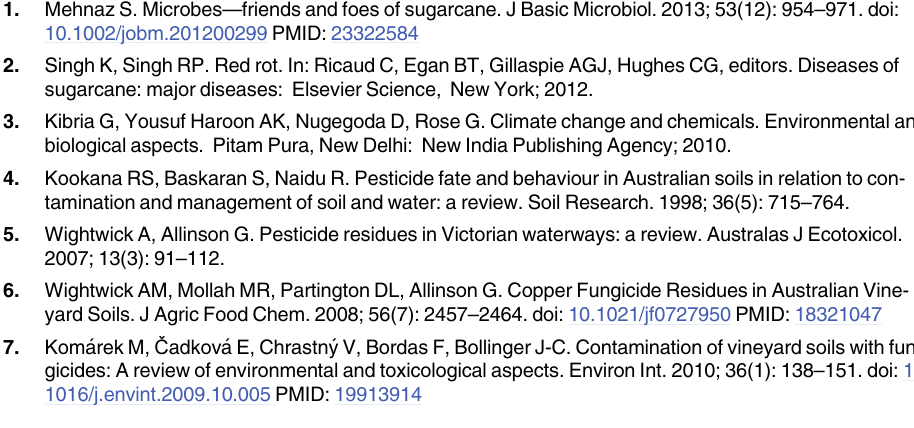
S3 Table. Nucleotide Sequence of aurI from P . chlororaphis subsp. aurantiaca StFRB508. S4 Table. Calibration equation and limit of quantification used for quantification of the corresponding AHLs. S5 Table. Measured pH values of P . aurantiaca PB-St2 culture supernatants at different growth intervals. S6 Table. Sequence alignment of